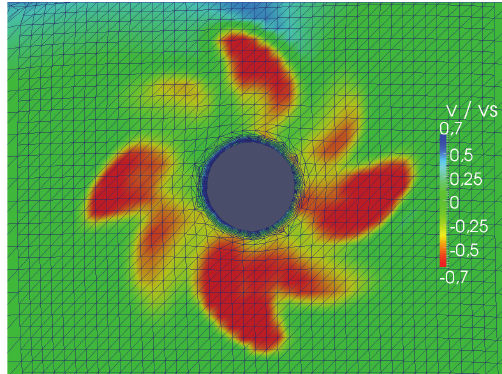
Figure 23: Normalised velocities in a transverse cut aft of the propeller region.